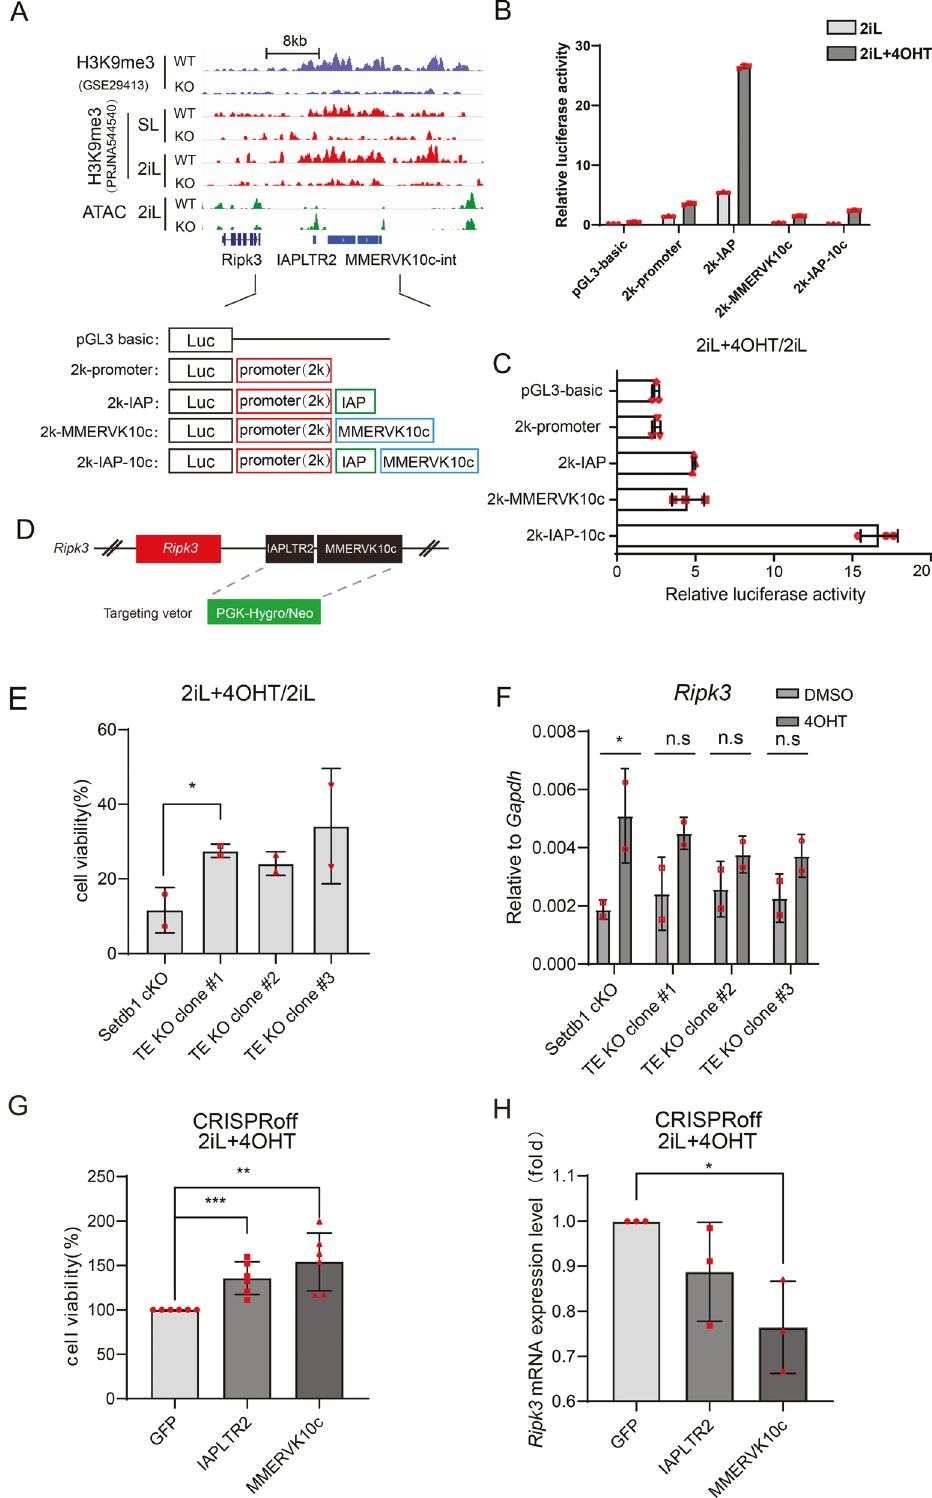
(Fig. 4C). Further experiments showed that deletion of IAPLTR2_Mm and MMERVK10c-int elements at the upstream of Ripk3 weakened Ripk3 expression and rescued cell viability in the Setdb1 knockout ES cells (Fig. 4D – F). Moreover, we used dCas9 system to inhibit IAPLTR2 and MMERVK10c-int expression (Fig. S3A). It showed that inhibition of IAPLTR2 and MMERVK10c- Cell Death and Disease (2023)